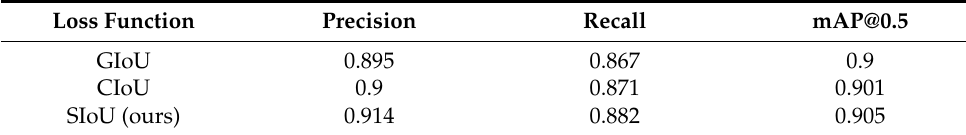
Table 5. Performances of different loss function.